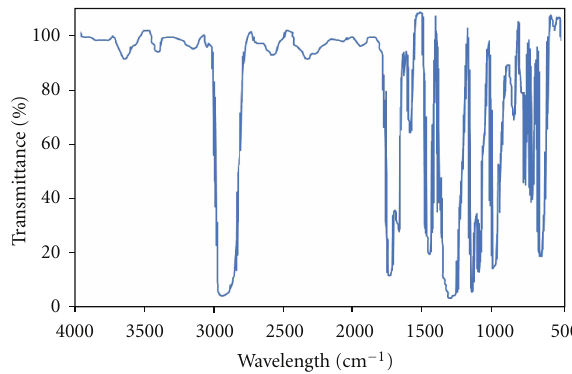
Figure 9: FTIR spectrum of sample code (nZ 5 ) after treating 45 days with UV